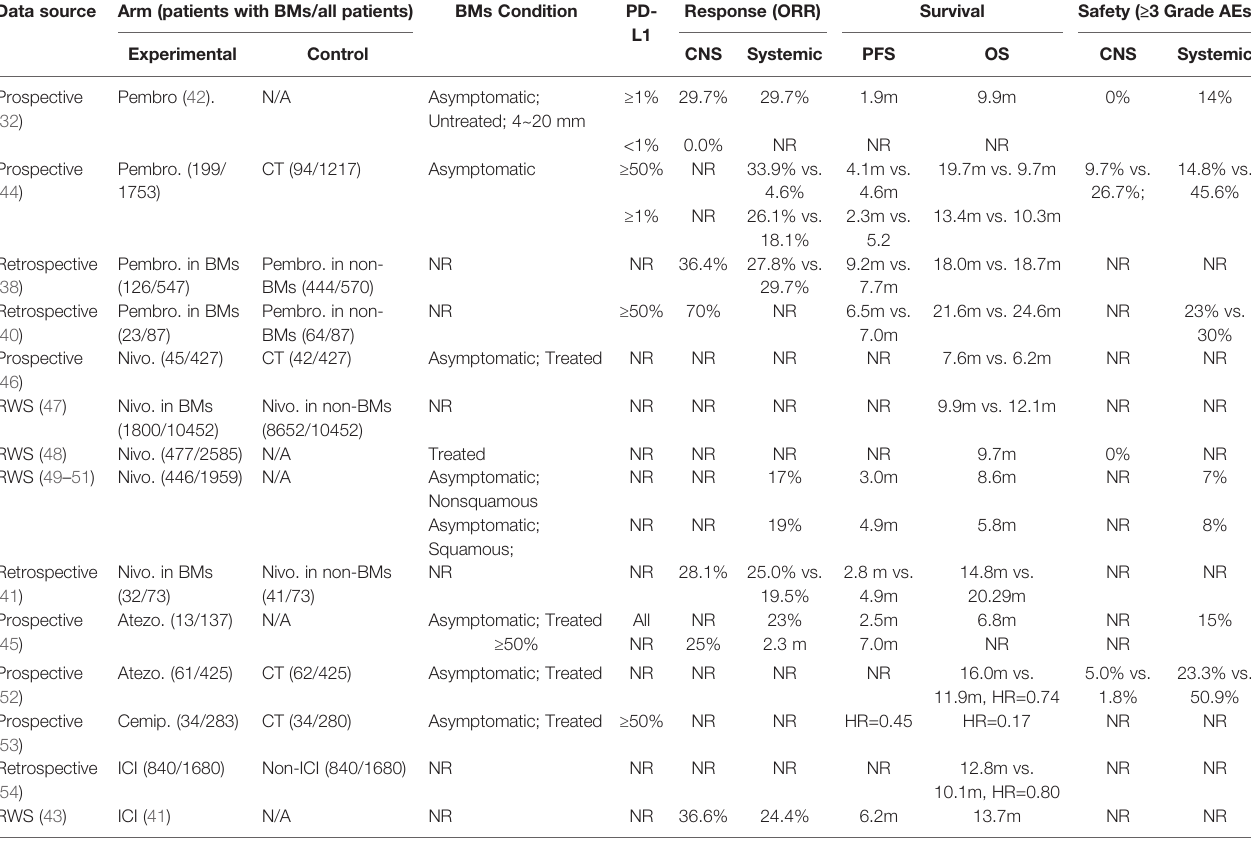
TABLE 1 | Clinical investigations of ICI monotherapy in the treatment of NSCLC patients with BMs. Data source Arm (patients with BMs/all patients)